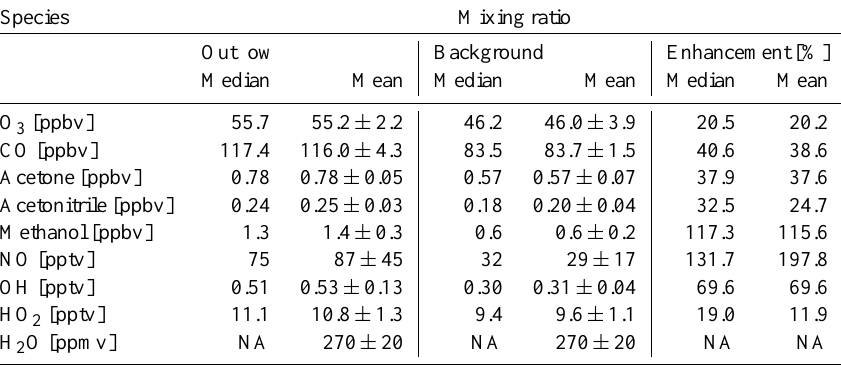
Table 2. Measured mixing ratios of different species in the outflow of the Cb. For H 2 O an estimation of the mixing ratio from earlier GABRIEL flights was necessary because of an instrument failure during this